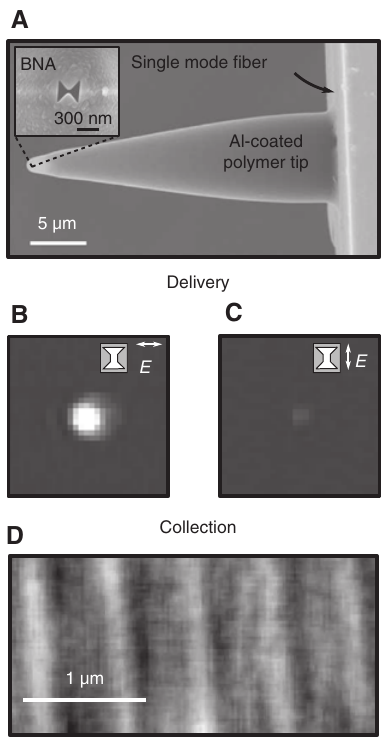
Figure 11: Integrated bowtie nanoantenna aperture at the end of an optical